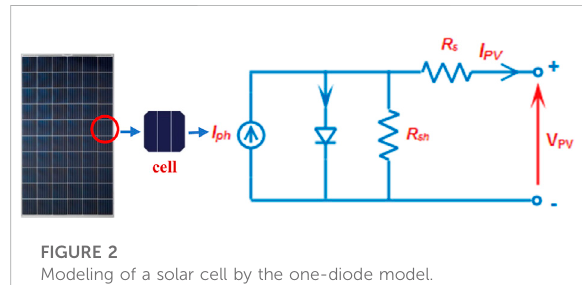
FIGURE 2 Modeling of a solar cell by the one-diode model.